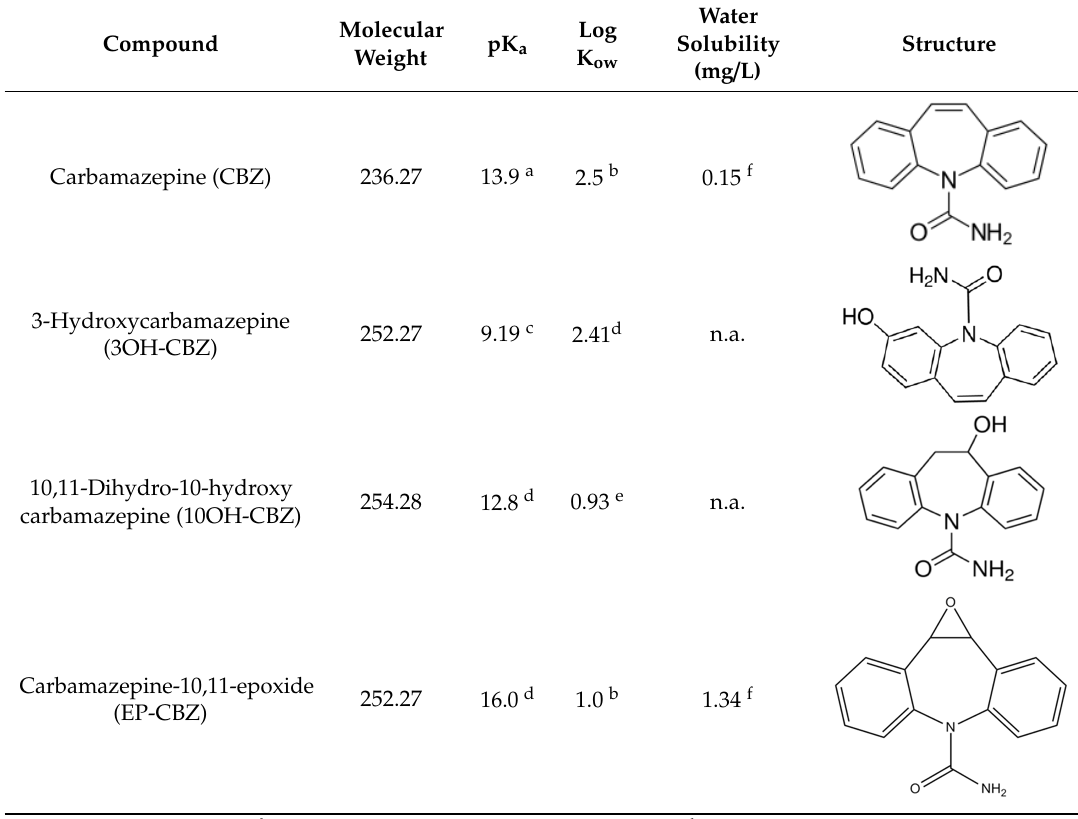
Table 2. Physical-chemical properties of the target compounds.